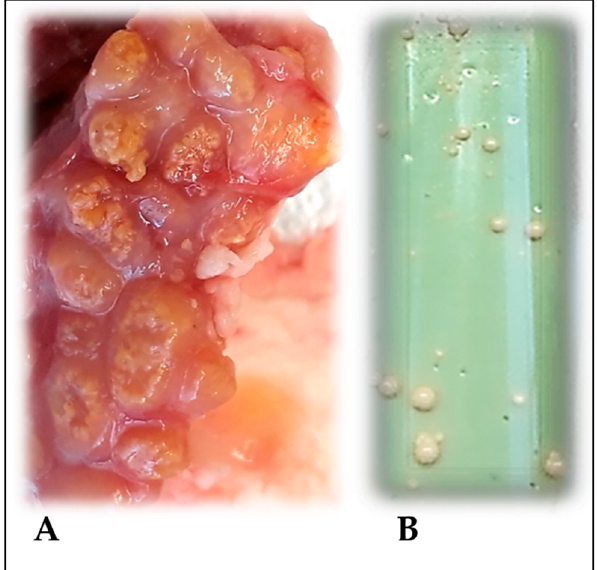
Figure 1. Tracheobronchial lymph nodes with visible lesions of Bovine tuberculosis (bTB) ( A ). Colonies of M. bovis in Stonebrink media ( B ).